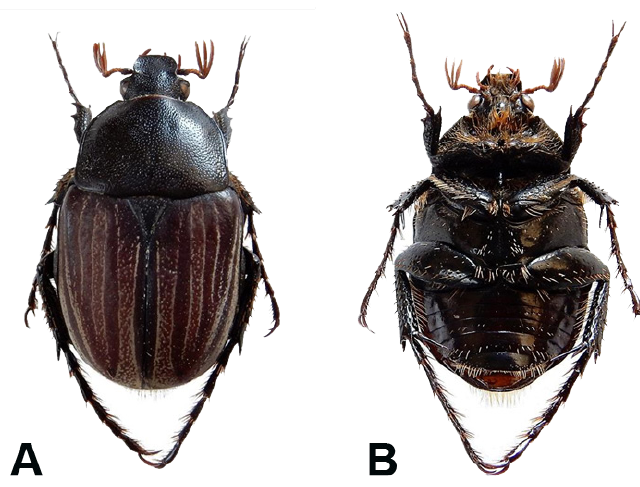
Fig. 1. Neoclita pringlei gen. et sp. nov., holotype, ♂, total length = 16.3 mm. A . Habitus, dorsal view. R. Perissinotto and L. Clennell leg.)